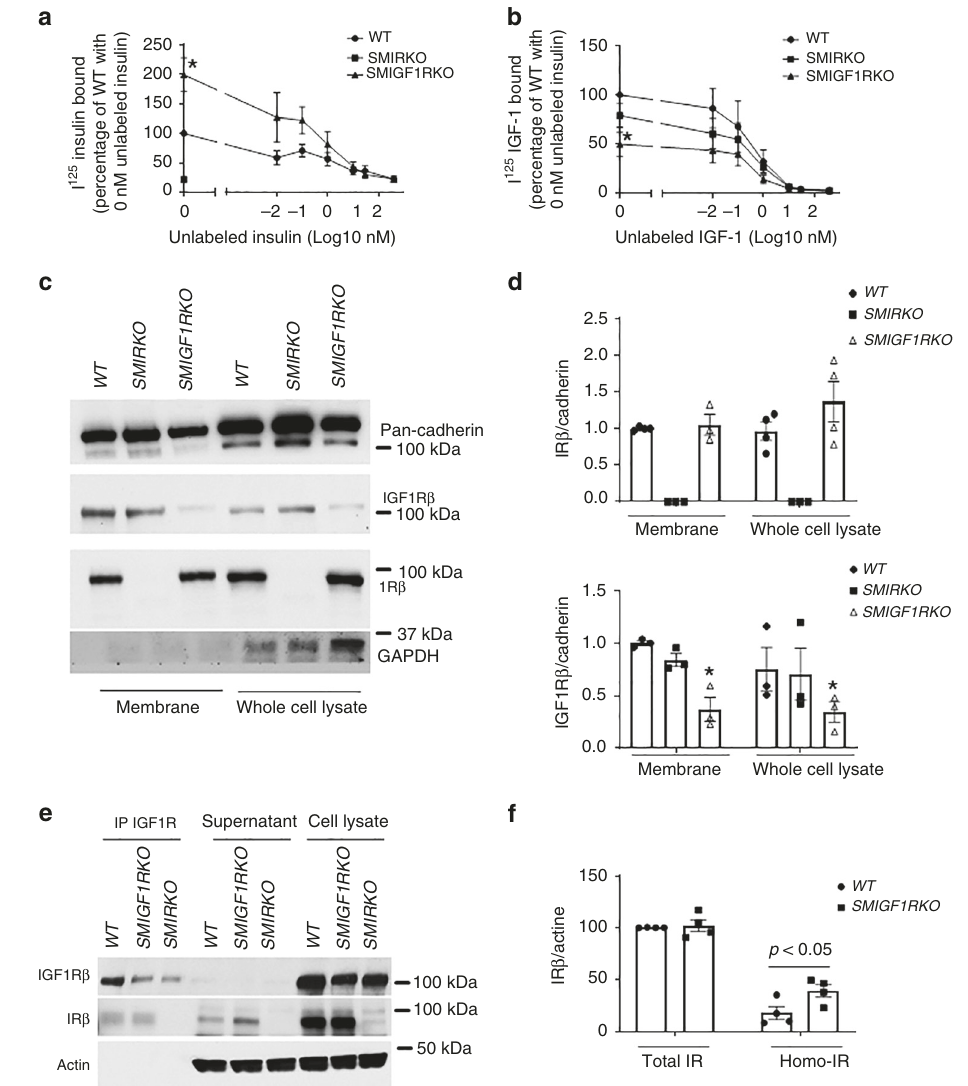
Fig. 4 Characterization of homo-IR/IGF1R and hetero-IR/IGF1R on signaling in WT , SMIRKO , or SMIGF1RKO VSMCs. a , b Insulin ( a ) or IGF-1 ( b ) binding. The VSMCs were incubated with mixture of I 125- labeled insulin and different dose of unlabeled insulin ( a ) or mixture of I 125- labeled IGF-1 and different dose of unlabeled IGF-1 ( b ) for 5 h on ice. Insulin or IGF-1 binding was determined by scintillation counter ( a , n = 5 for WT and SMIGF1RKO at 0 nM unlabeled insulin; n = 3 for WT and SMIGF1RKO at 0.01, 30, and 400 nM unlabeled insulin; n = 4 for WT and SMIGF1RKO at 0.1, 1, and 10nM unlabeled insulin; b , n = 3 for each group; * p < 0.05 SMIGF1RKO vs. WT ). c , d IR and IGF1R on cell surface. The cell membrane protein was labeled with biotin. The biotin-conjugated protein was precepitated by avidin-conjugated beads. The levels of IGF1R and IR on cell surface were determined by western blotting ( n = 4 for WT memtrane, WT total, and SMIGF1RKO total; n = 3 for SMIRKO membrane, SMIRKO total, and SMIGF1RKO membrane, * p < 0.05 SMIGF1RKO vs. WT ). e , f Ratio of homo-IR and hetero-IR/IGF1R. The cell lysates were immunoprecipitated with anti-IGF1R antibody. The levels of IR and IGF1R in immunoprecipitation, supernatant after immunoprecipitation with anti-IGF1R antibody and whole-cell lysates without immunoprecipitation were determined by western blotting. The IR in immunoprecipitation was IR from hetero-IR/IGF1R, and the remaining IR in supernatant was homo-IR. The IR in whole-cell lysates included homo-IR and IR in hetero-IR/IGF1R ( n = 4 for each group). The data are mean± SEM. Two-tailed t test. Source data are provided as a Source Data fi le IGF1R-ICD and IGF1R-ECD/IR-ICD. The results showed that IR-intracellular domain VSMCs, whereas p-Akt induced by IGF- insulin ’ s activation of p-Akt in cells overexpressing IR- 1 in IGF1R-ECD/IR-ICD VSMCs and IR-ECD/IGF1R-ICD extracellular domain/IGF1R-intracellular domain was sevenfold VSMCs were comparable (Fig. 5a – d). These results support greater than WT cells and IGF1R-extracellular domain/IR- strongly the conclusion that the enhanced effect of insulin in intracellular domain cells as before. In addition, insulin ’ s effect SMIGF1RKO vs. WT were due to enhanced binding of insulin to on p-Akt in cells expressing IR-ECD/IGF1R-ICD and IGF1R- the IR α /IR α homodimers, and not due to activation of IR β /IR β ECD/IR-ICD together were greatly decreased compared with cells homodimers. To support further that IR/IR homodimers are which expressed only IR-ECD/IGF1R-ICD (Fig. 5e, f). responsible for enhancing insulin ’ s actions in VSMCs from SMIGF1RKO mice, VSMCs with complete deletions of both endogenous IR and IGF1R were overexpressed with IR-ECD/ Insulin targets in VSMCs . To identify the speci fi c downstream IGF1R-ICD alone, IGF1R-ECD/IR-ICD alone or both IR-ECD/ cellular targets of IR that are mediating its enhanced effects on NATURE COMMUNICATIONS| (2019) 10:4427